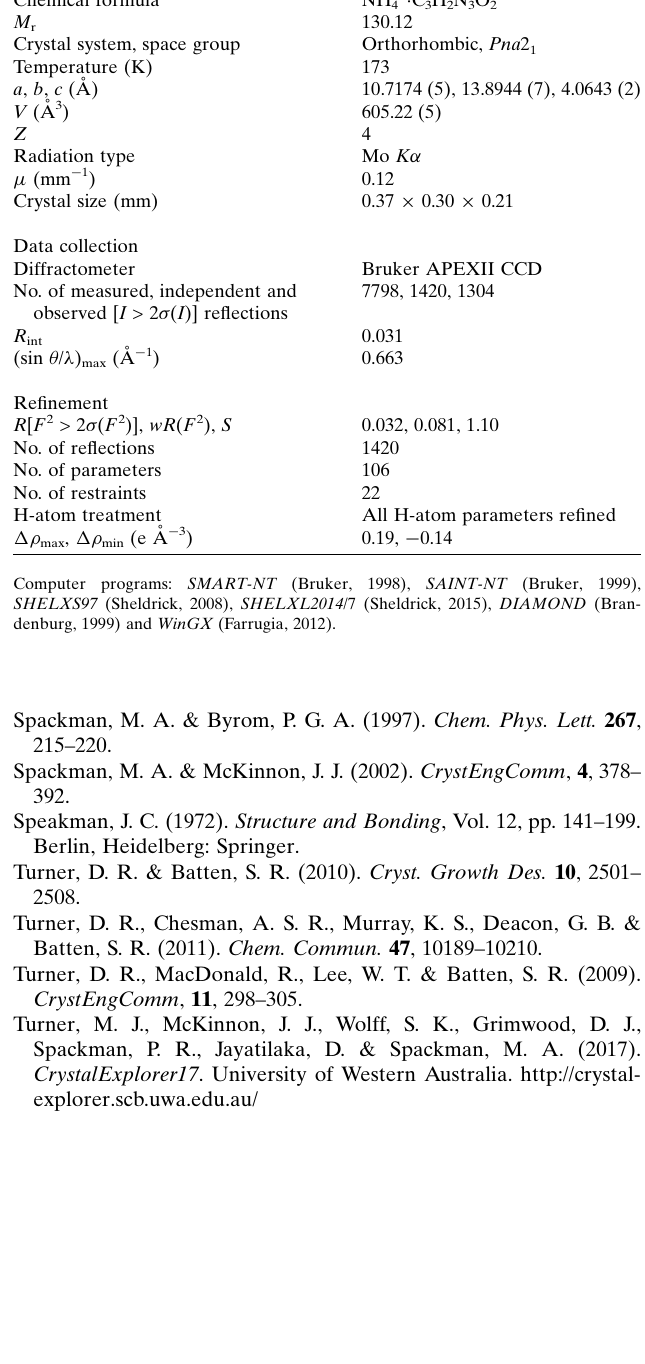
Crystal data Chemical